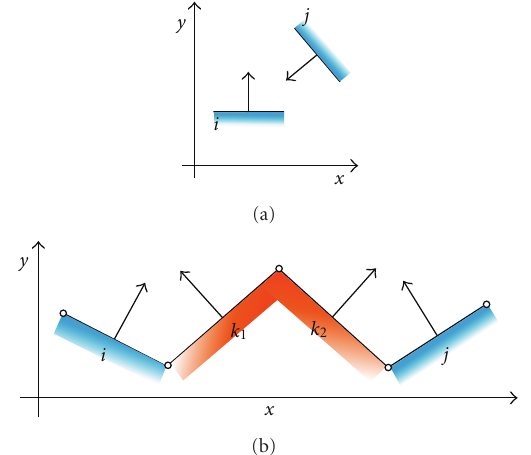
Figure 1: Two tests are performed to verify if two faces have a view factor F ij / = 0.